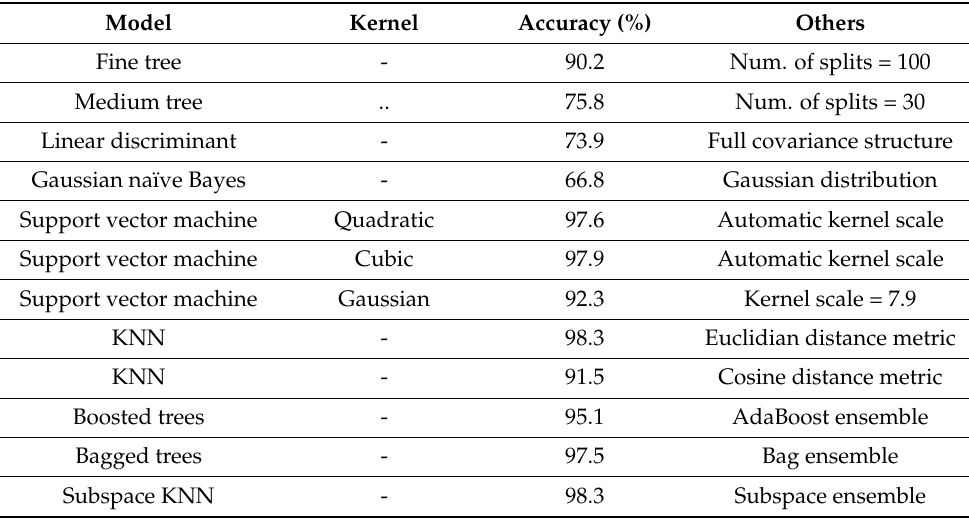
Table 6. Summary of different ML-based models